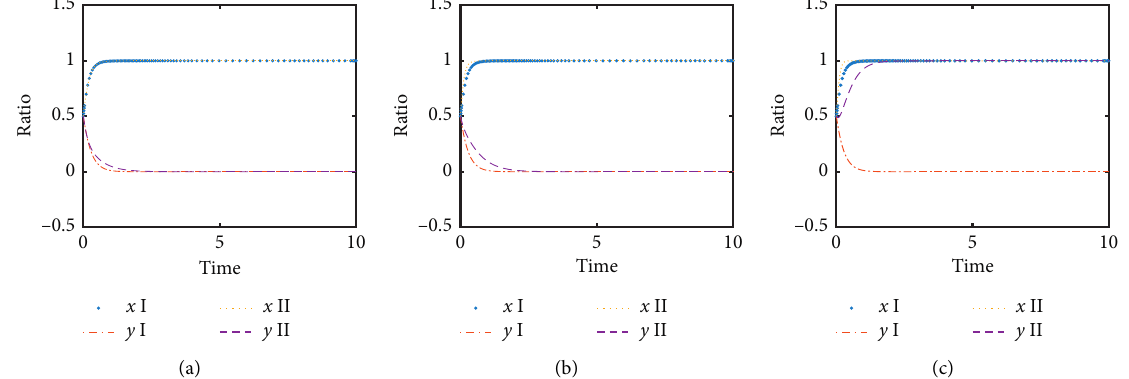
� 1 , λ � 0 . 3. (b) λ � 0 . 5 , λ � 0 . 8. g s g s